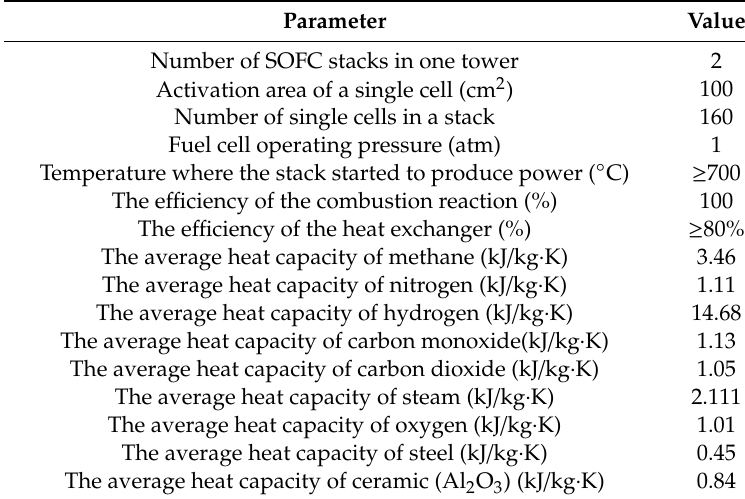
Table 2. The base parameters for the dynamic analysis model.